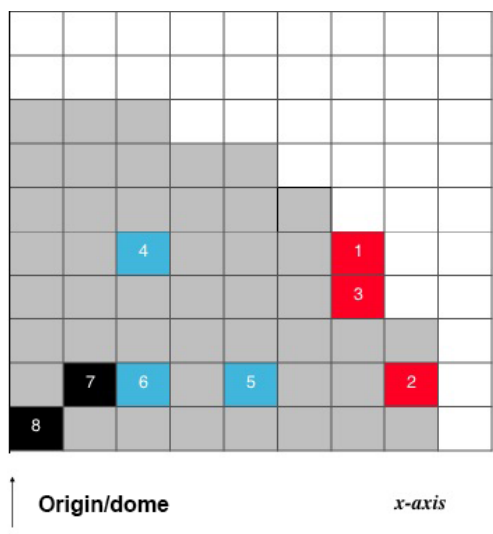
Figure 5. Grid map used to interpret the following box plots in Fig. 6. Eight randomly chosen grid points are selected for testing predictions; these are not the same as the measurement locations. is the Only one quadrant of the glacier is shown due to symmetry, as is dome done in Figs. 9, 10, and 12 of Bueler et al. (2005), and the width of is the error- interior each cell is 10 5 m. Additionally, the red squares indicate locations is the error- margin at or close to the margin, the blue squares indicate locations that are between the dome and margin of the glacier, and the black squares indicate locations at or close to the dome of the glacier. Moreover, glacier grid squares with non-zero thickness are shaded in grey to indicate the glacier